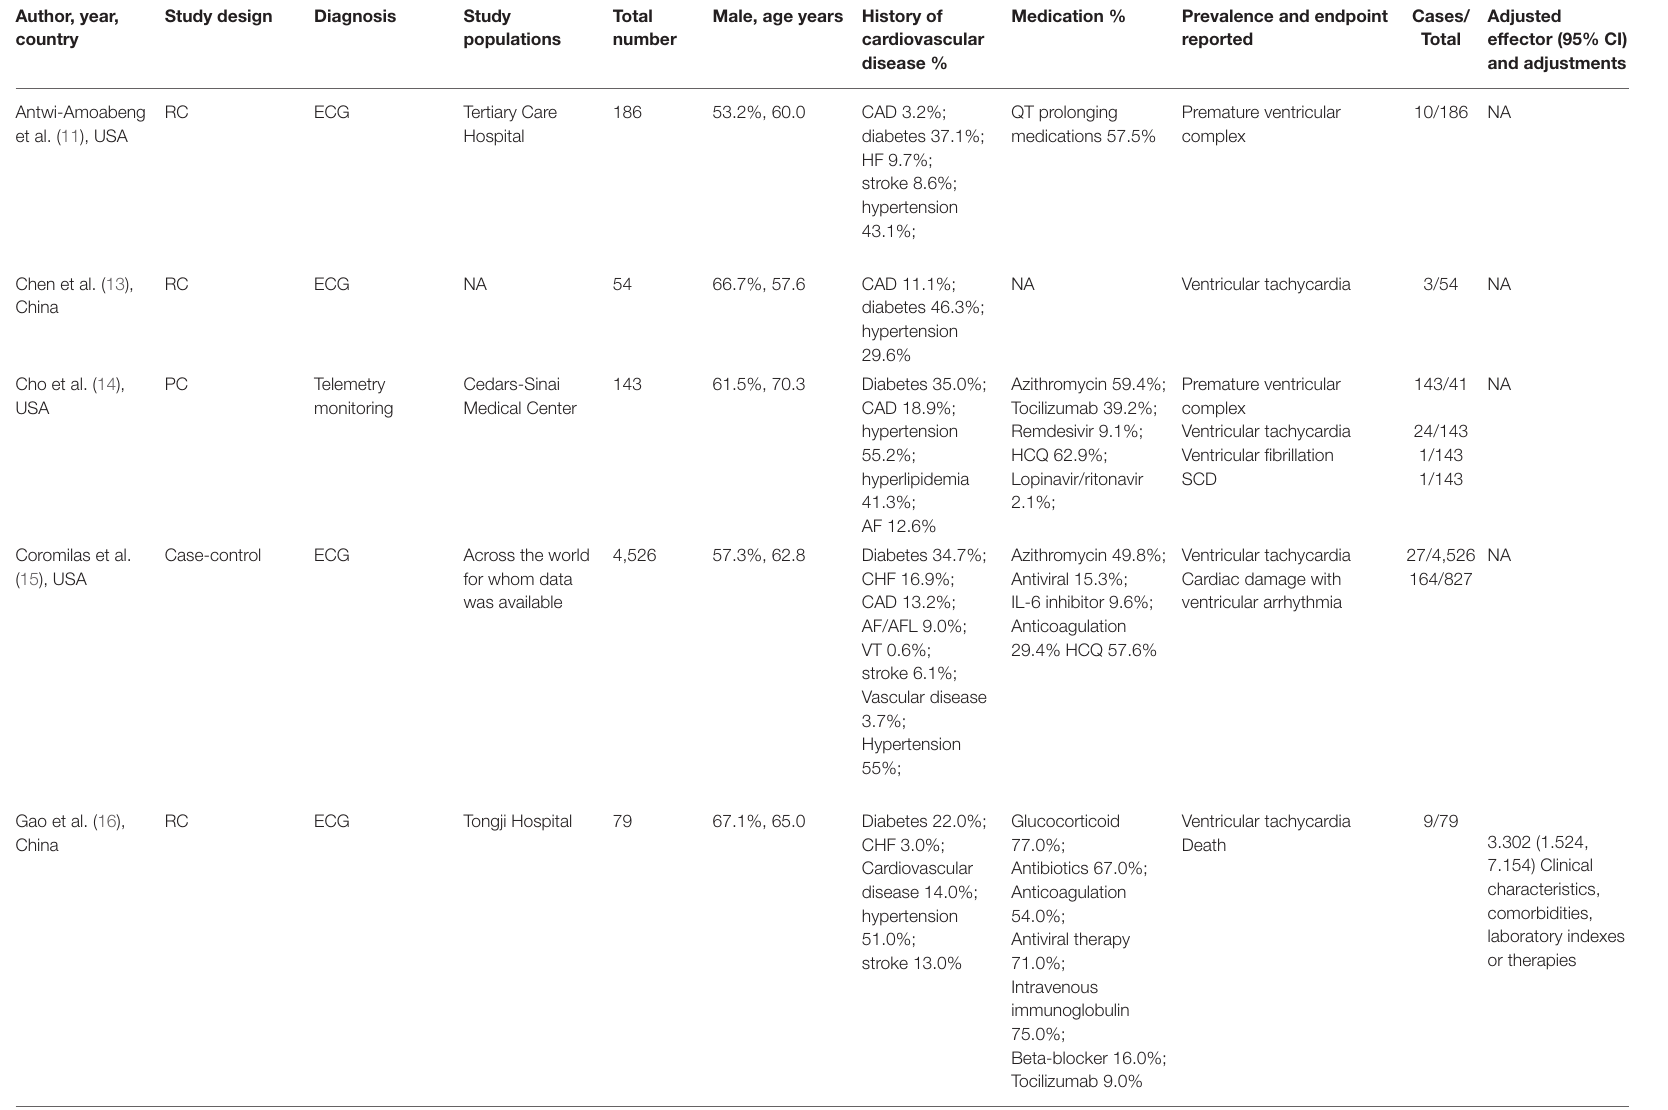
TABLE 1 | Basic characteristics of the articles included in the